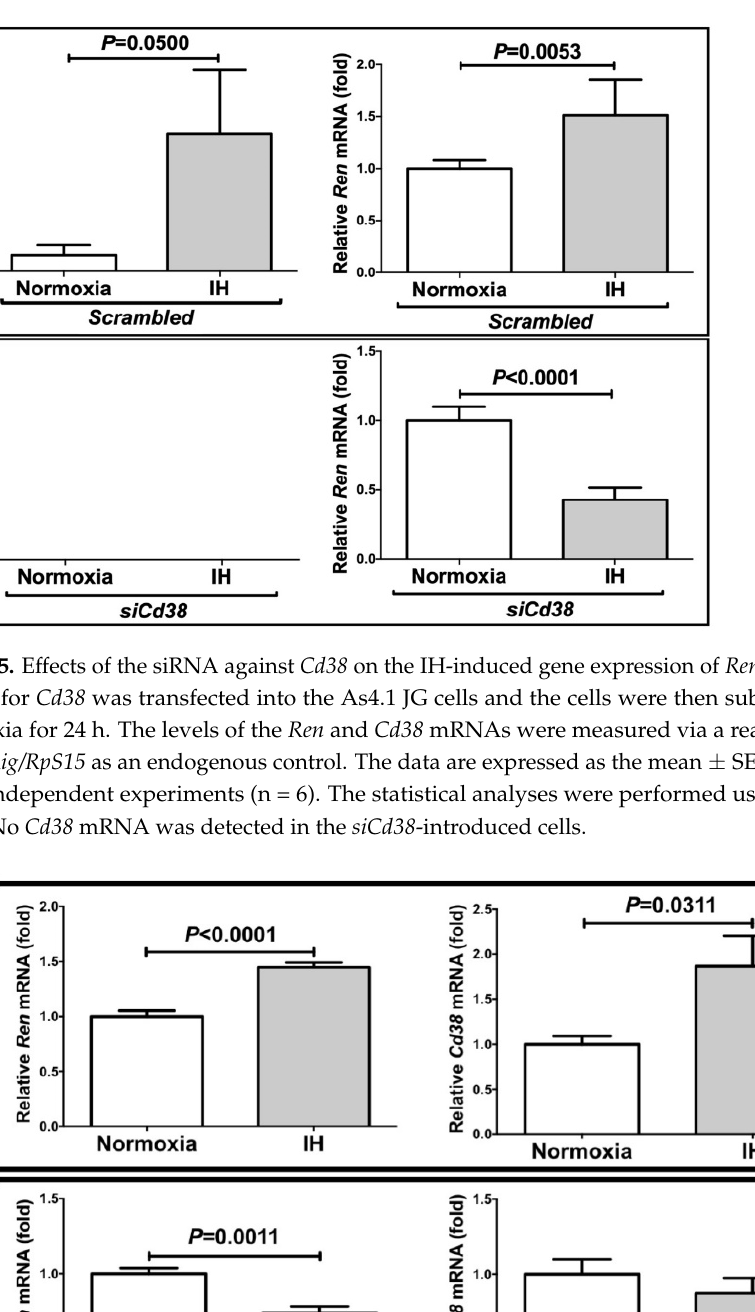
4 of 16 Figure 4. Relative protein expression of Cd38 in the As4.1 JG cells subjected to IH. A representative immunoblot is shown in right panel. The relative expression of the Cd38 is arbitrarily presented. The Cd38 band densities were quantified using an image analysis and then normalized to β -actin, as measured in the same blot. Each bar represents the mean values of four independent experiments. The results are expressed as the mean ± SE in arbitrary units. 2.2. Downregulation of Cd38 Attenuated the Ren Increase in As4.1 Cells Treated with Small Interfering RNA (siRNA) for Cd38 To investigate the mechanism of Ren expression in the As4.1 cells, the Cd38 gene was